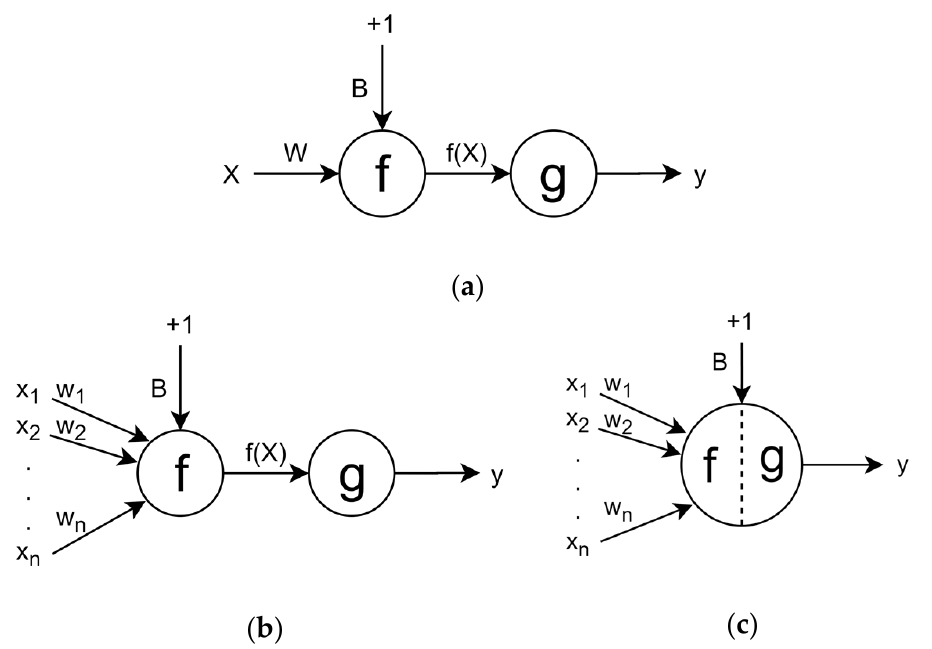
Figure 2. ( a ) Perceptron with single value input, ( b ) perceptron with multi-value input, and ( c ) merging perceptron and activation function.